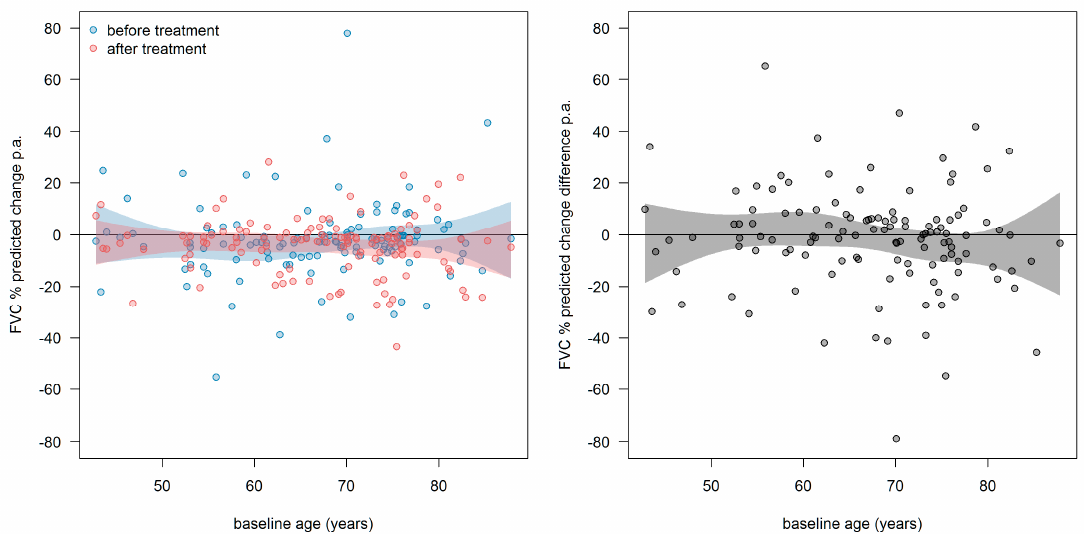
Figure 9. Distribution of the FVC slope and slope differences in dependency of age at t0. Left: slopes before (blue) and after (red) treatment. Right: slope-differences (after-before). Every point represents one patient. The curvy surfaces are the 95th confidence interval for mean values of age at t0. Abbreviations: FVC—forced vital capacity.